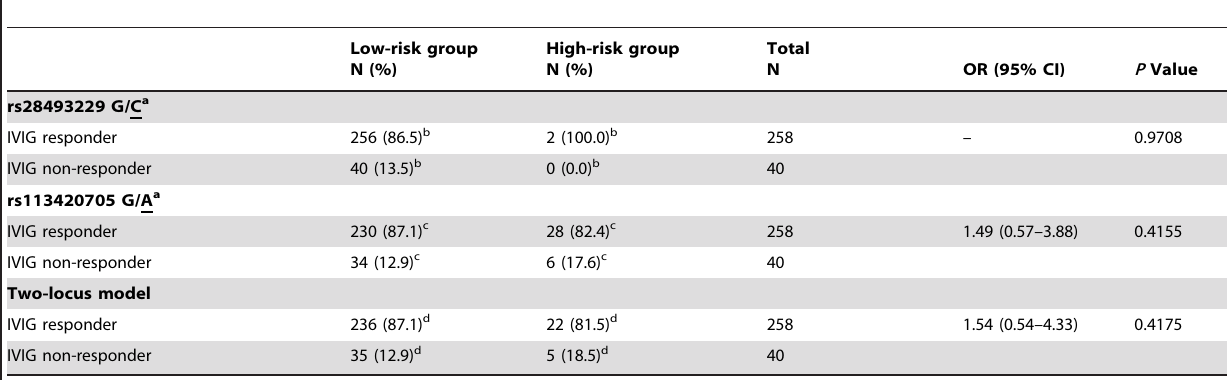
Table 3. Association of rs28493229 C allele and rs113420705 A allele with IVIG response in KD